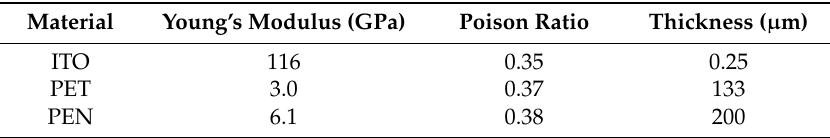
Table 1. Material properties and parameters used in the 3D FEA modeling